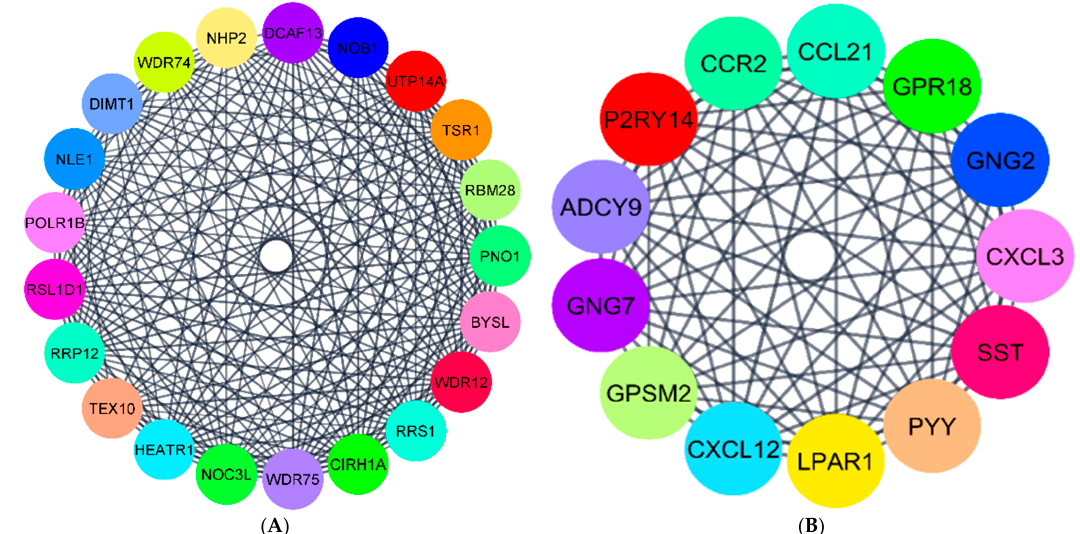
Figure 6. ( A , B ) The most significant modules of DEGs in G1. Cluster1 and Cluster2 were obtained with the MCODE plugin in Cytoscape.